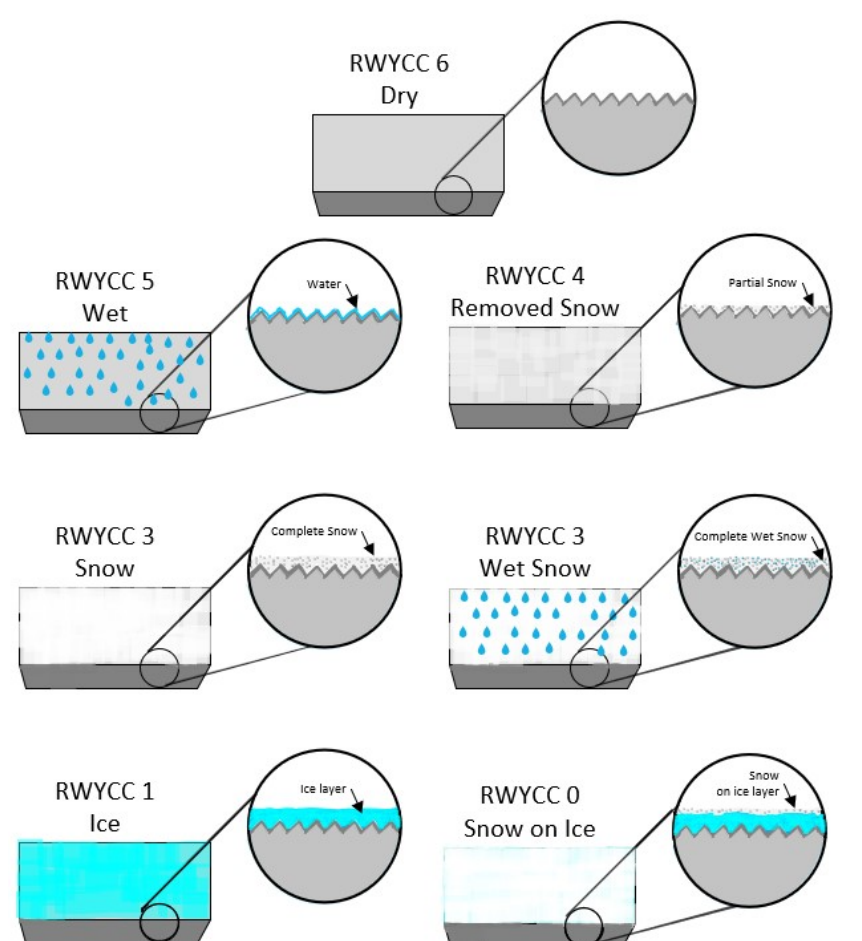
Figure 3. Schematic of the different winter conditions presented in the GRF [22] and a close-up view of their impact on the surface texture.